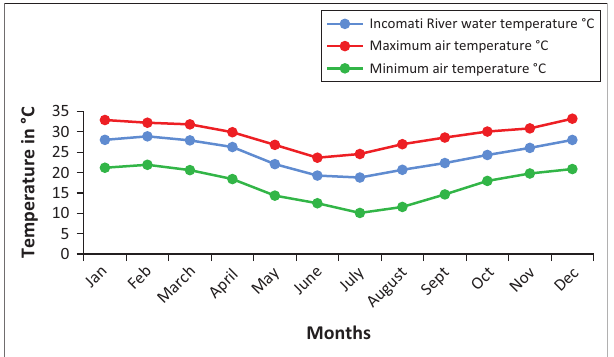
FIGURE 3: Graph indicating water and air temperature for the months January–December 2003 in the Incomati River.